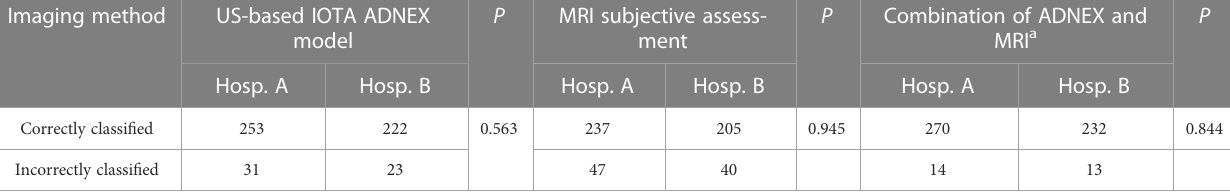
TABLE 2 Comparison of the diagnostic performances of the methods at the two institutions. Imaging method